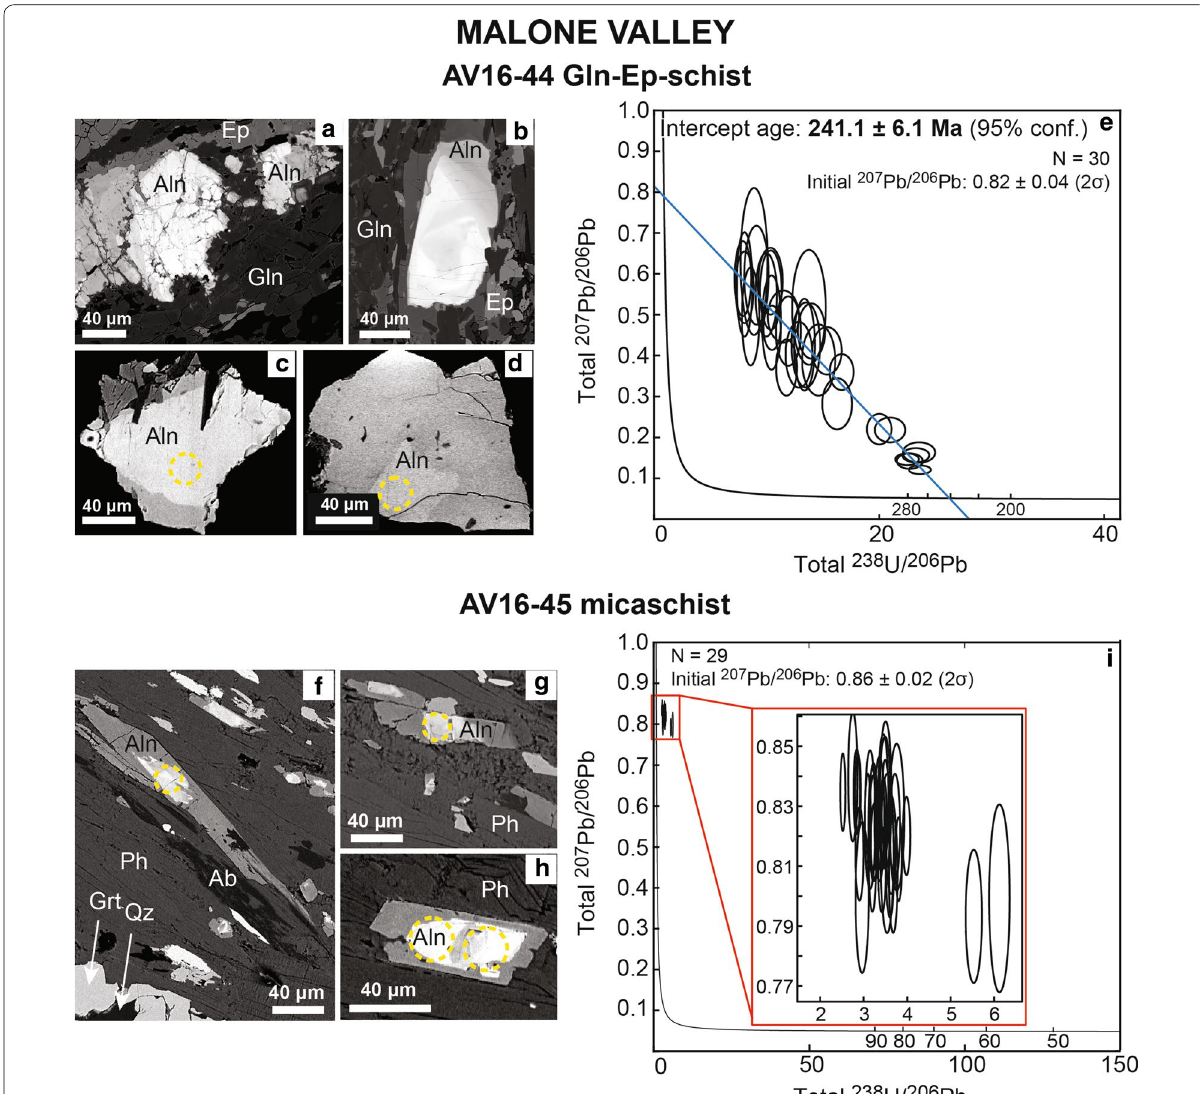
Fig. 4 Allanite in samples from Malone Valley. Blueschist AV16-44: a , b Thin section BSE images of allanite (Aln) associated to glaucophane (Gln) and epidote (Ep). c , d BSE images of allanite (Aln) in a grain mount. e Tera-Wasserburg plot for LA-ICP-MS U–Pb allanite analyses. Data-point error ellipses are 2σ. Micaschist AV16-45: f – h Thin section BSE images of allanite (Aln) associated to phengite (Ph) in the main foliation. Garnet (Grt) and quartz (Qz) are part of the HP mineral assemblage; albite (Ab) is retrograde. i Tera-Wasserburg plot for LA-ICP-MS U–Pb allanite analyses. Data-point